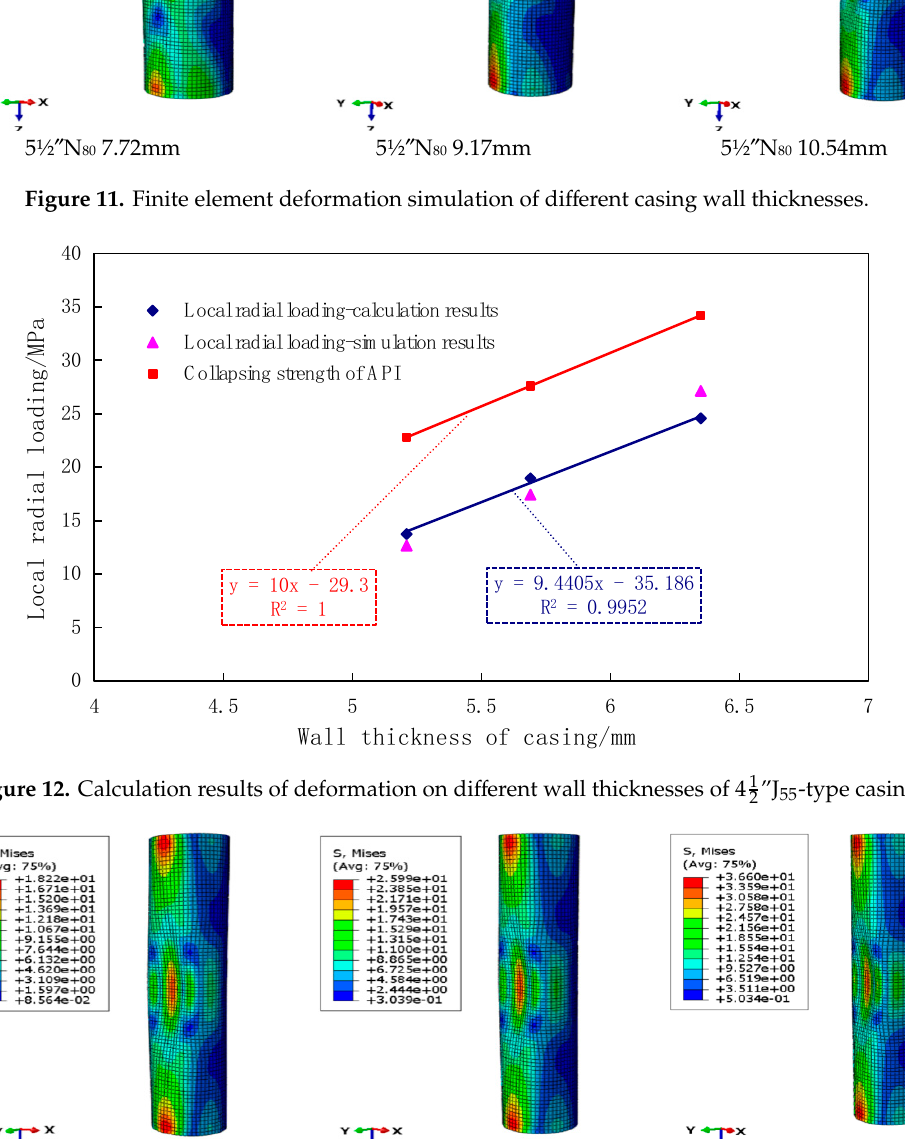
Figure 13. Finite element simulation of deformation on different casing wall thicknesses.